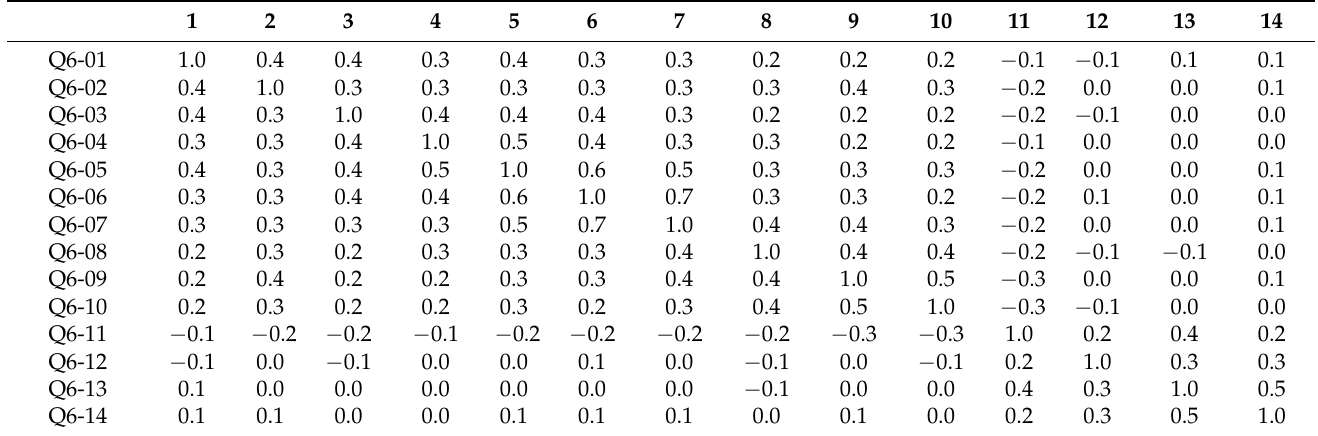
Table 4. Cross-correlation coefficients. Hungarian case.